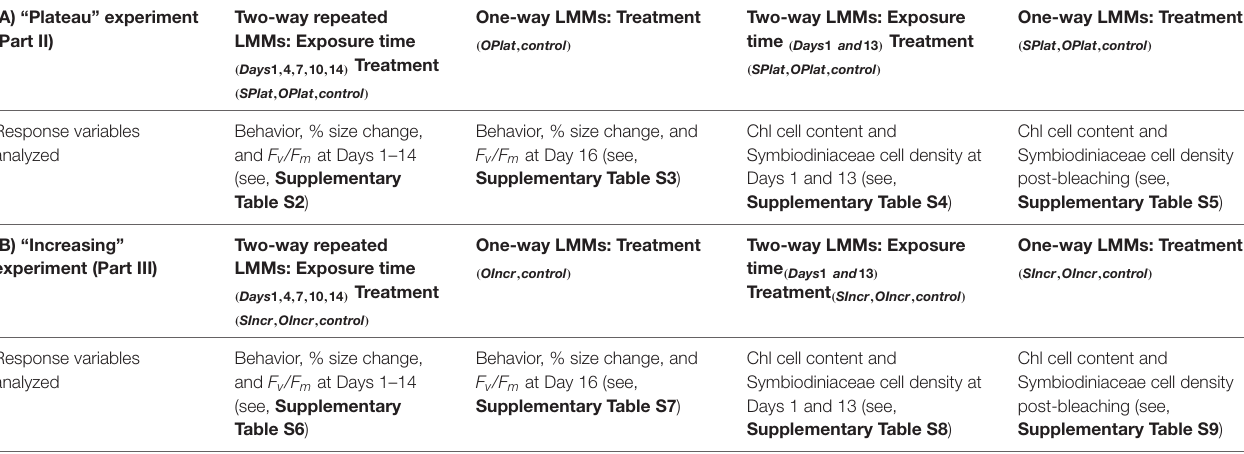
TABLE 1 | Summary of Linear Mixed Models (LMMs) conducted to analyze biological response variables in (A) the “Plateau experiment” (Part II) and (B) the “Increasing” experiment (Part